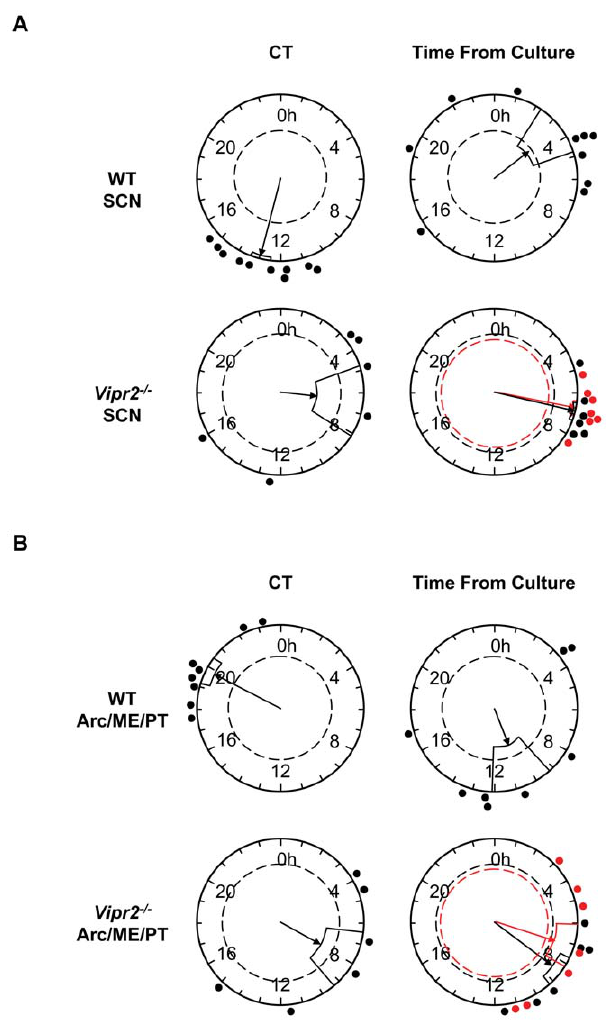
Figure 3. Rayleigh Plots Showing the Effect of Culture Preparation on Peak Phase of PER2::LUC Expression in SCN and Arc/ME/PT. Plots show peak PER2::LUC phase for WT and Vipr2 2 / 2 SCN and Arc/ME/PT plotted as either circadian time (CT; based on behavioral rhythms) or time of peak bioluminescence after culture preparation (Time From Culture). CT plots include data from behaviorally rhythmic mice only (black data points, arrow and dashed line) while time from culture plots show data both from behaviorally rhythmic (black) and arrhythmic (red) mice, analyzed separately. Black data points from behaviorally rhythmic mice on CT plots and time from cull plots are directly comparable. Red points from arrhythmic Vipr2 2 / 2 mice are included for subjective comparison. Both SCN and Arc/ME/PT from WT mice express peak PER2::LUC bioluminescence at a consistent circadian phase,regardlessofcull/culturetime(peakphaseiscorrelatedwithCT not with time from culture). However, Vipr2 2 / 2 SCN and Arc/ME/PT always peak the same number of hours after culture preparation, showing these tissues to be reset by this process (peak phase correlated with time from culture not CT. Note that phase is well clustered for WT CT plots (upper left of panels A and B ) and Vipr2 2 / 2 time fromcultureplots (lowerright of panels A and B ). Filled circles indicate the phase of peak bioluminescence in individual cultures. The direction of an arrow indicates the mean phase vector and its length shows significance relative to the ( p =0.05) significance threshold indicated by the inner broken circle. Boxes surrounding arrow heads show variance of phase between